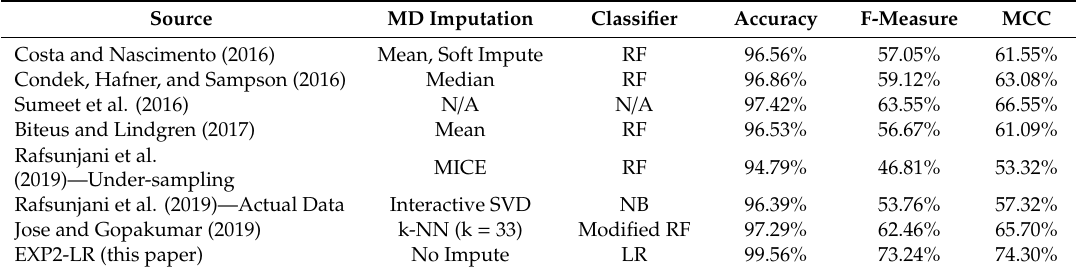
Table 7. Comparison of the proposed approach to methods reported in previous studies based on accuracy, F-measure, and Matthews correlation coe ffi cient (MCC) over the test